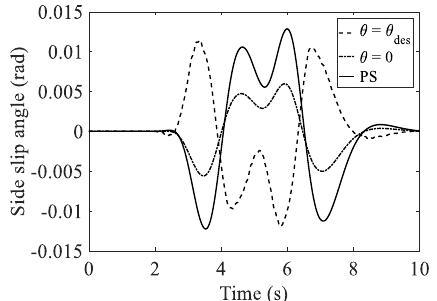
Figure 18. Yaw rate.